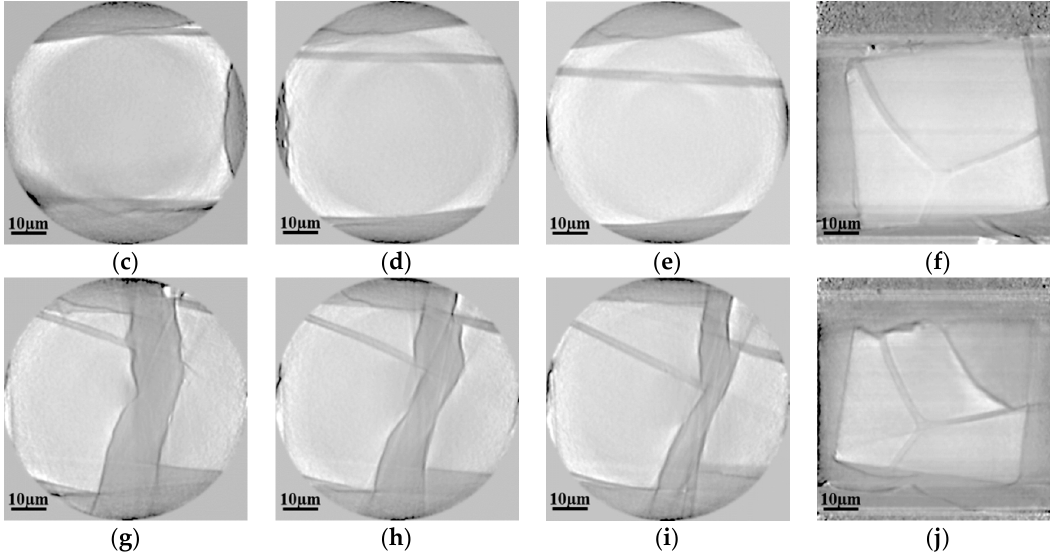
Figure 7. Scheme of in-situ X-Ray Computed Tomography indentation of P. margaritifera shells along LD, 3D reconstruction of the sample before ( a ) and after ( b ) in-situ indentation test, horizontal and vertical virtual cross-sections of the shell and 3D reconstruction acquired before ( c – f ) and after ( g – j ) the indentation test.